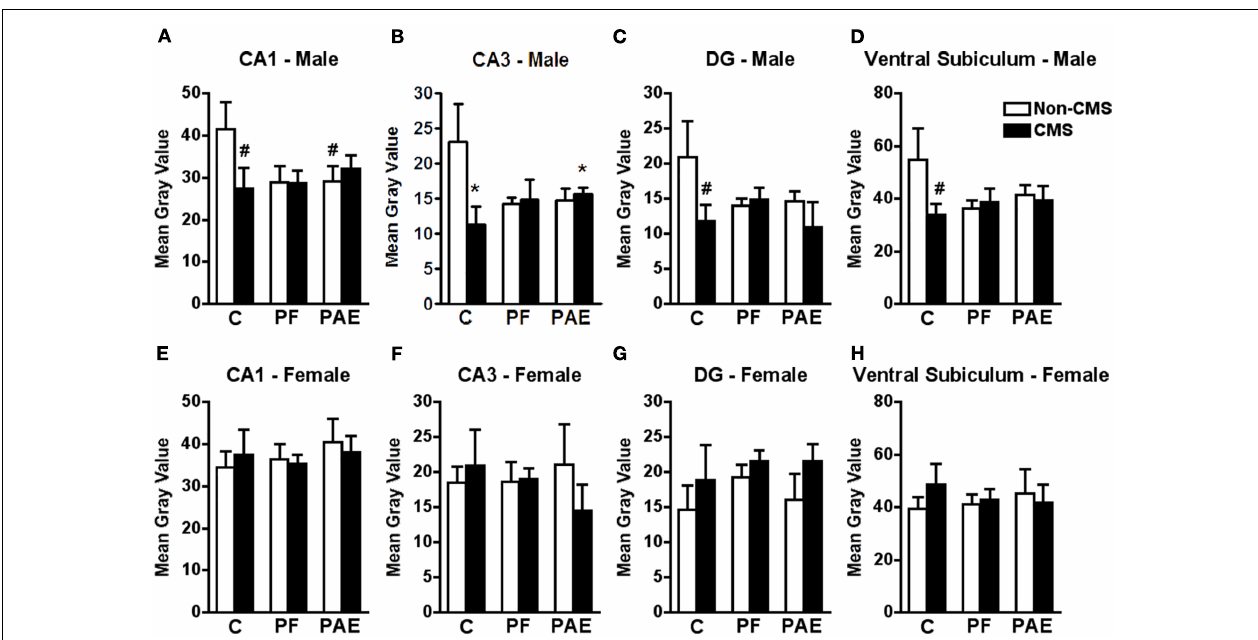
(C,G) , and ventral subiculum (D,H) . *Indicates a significant interaction between prenatal treatment and CMS exposure, where the control non-CMS group is different from control CMS and PAE CMS groups; # indicates that control CMS and PAE non-CMS are different from control non-CMS based on a priori comparisons ( n = 3–5 for all